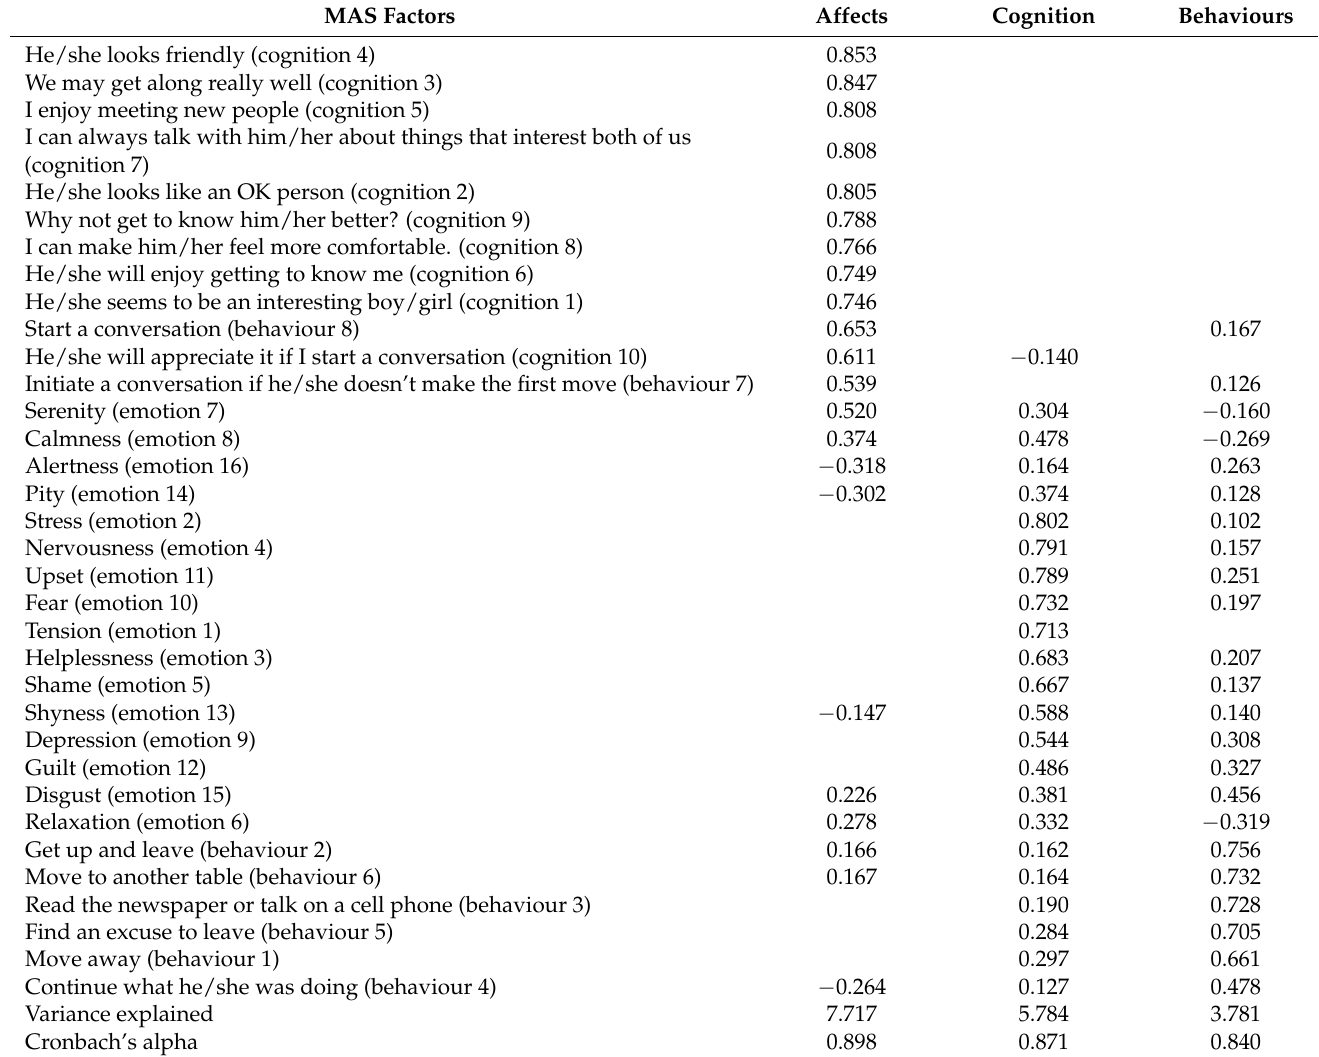
Table 2. Principal component factor analyses of the MAS-PL scale (Varimax rotation and Cron- bach’s alpha).